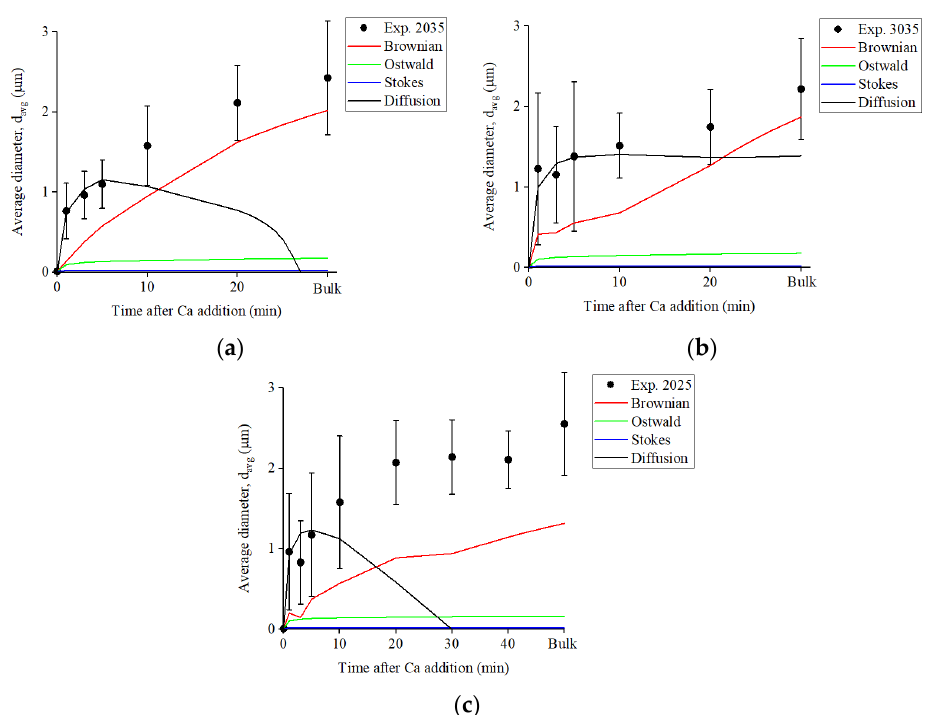
Figure 9. Comparison of the average diameters of CaS type inclusions in samples taken in ( a ) Exp. 2035, ( b ) Exp. 3035, and ( c ) Exp. 2025, and predicted using different coarsening mechanisms.